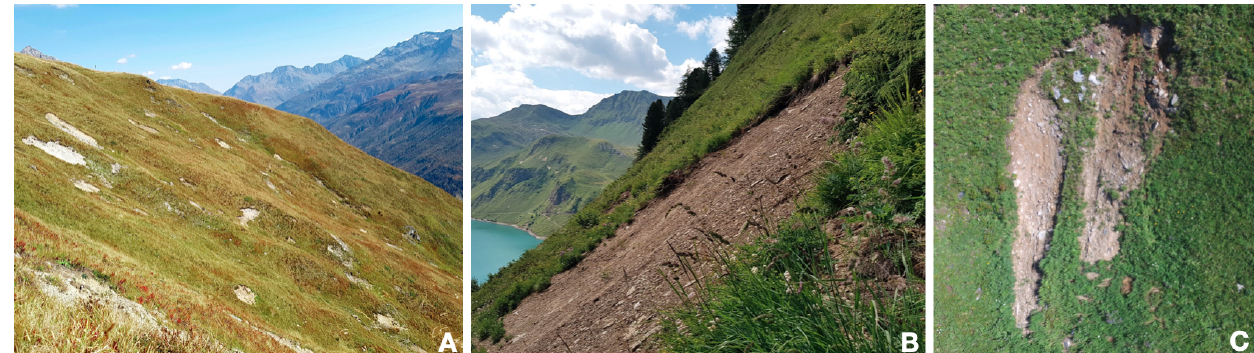
Figure 1. Images showing examples of shallow landslides. Shallow-landslide sites show displaced topsoil layers and have a distinct boundary to the vegetation. (a) Taken in the Urseren valley, showing a larger section of a south-east-facing slope area affected by many shallow landslides (light-coloured patches). (b) Taken in Val Piora, showing a close-up of a shallow landslide facing south. (c) Showing an image taken with a UAV in Val Piora with an approximate length of 10m.